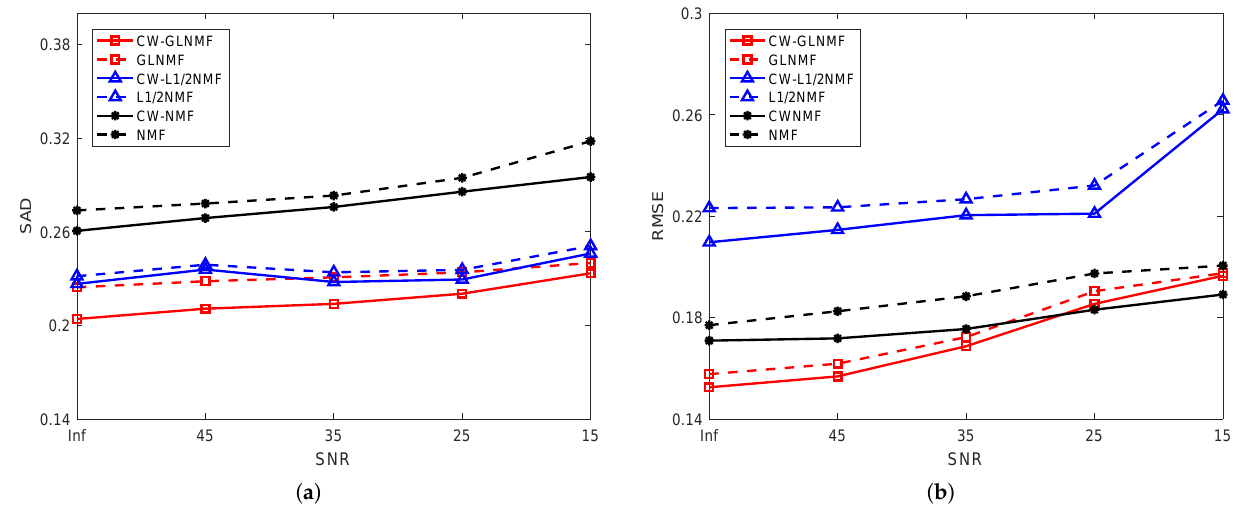
Figure 4. Results on synthetic data: ( a ) SAD and ( b ) RMSE as a function of SNR. Experiment 3 (convergence analysis): In this experiment, we analyze the convergence thetic data that are generated under the condition that SNR = 25 dB, P = 5, and θ =